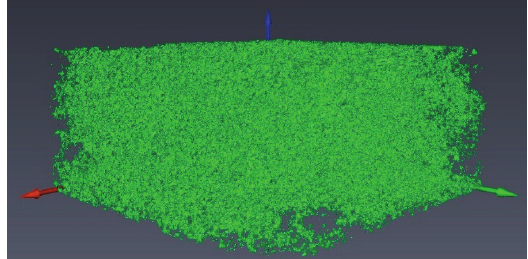
Fig. 3. Visualization of pore space of the sandstone (Carboniferous) skeleton, Avizo software, OGI-NRI in